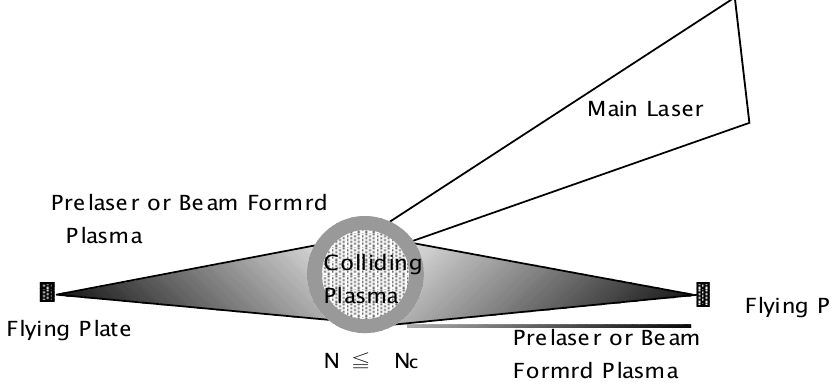
Figure 2. Model for the nuclear reaction with a cloud around nuclear